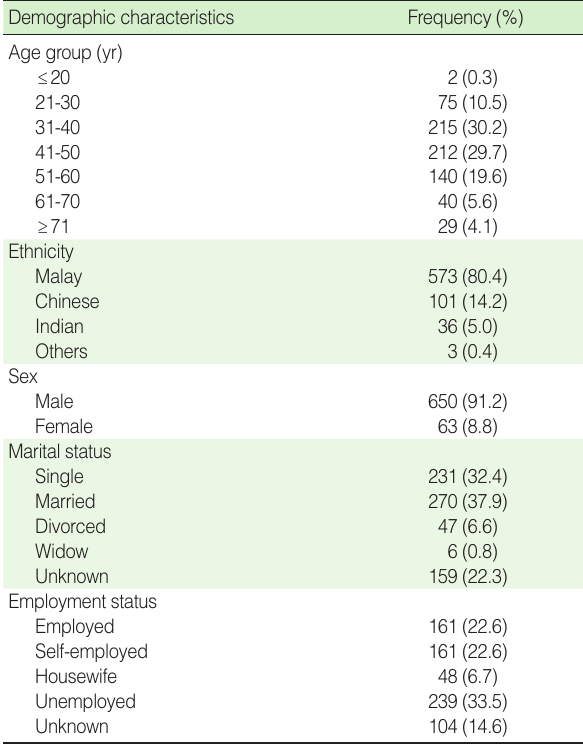
Table 1. Demographic characteristics of patients diagnosed with hepatitis C in the Kota Setar district, Kedah, Malaysia from 2009 to